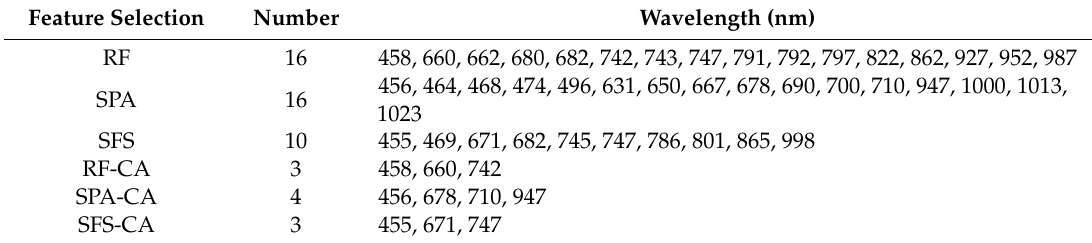
Figure 4. Correlation analysis (CA) among optimal wavelengths selected by ( a ) random frog (RF), ( b ) successive projections algorithm (SPA) and ( c ) sequential forward selection (SFS), respectively. Table 1. Optimal wavelengths selected by RF, SFS and SPA.